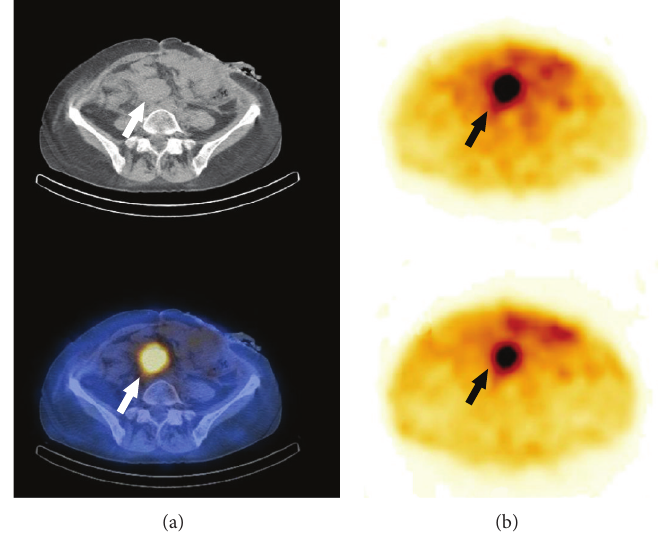
Figure 4: 56-year-old woman after ileum resection for carcinoid 15 months ago. Somatostatin receptor imaging with 111 In-pentetreotide, abdomen CT, SPECT and SPECT/CT, transversal slices. Metastasis of carcinoid in the preaortal lymph node ( arrow head ).